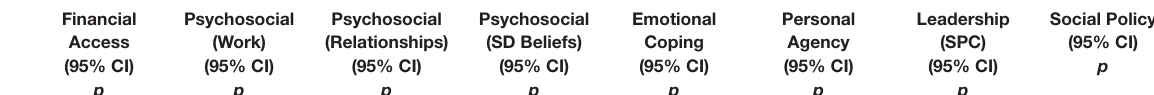
TABLE 7 | Direct effects for the mediation SEM Model